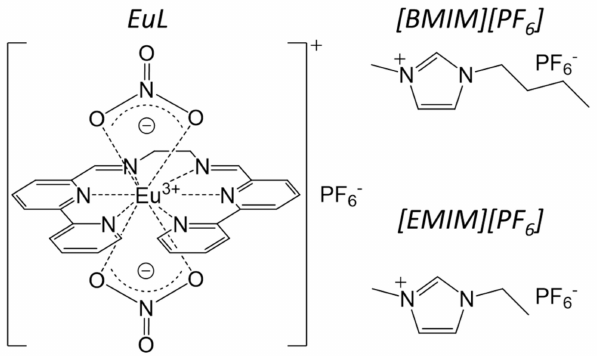
Figure 1. Molecular structures of the Eu complex (EuL) and the ionic liquids [BMIM][PF 6 ] and [EMIM][PF 6